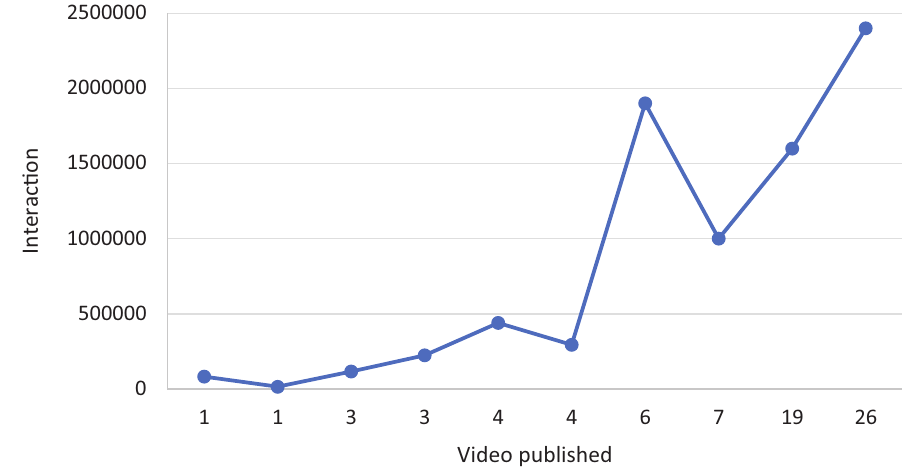
Figure 3. Correlation between channel interaction and number of videos